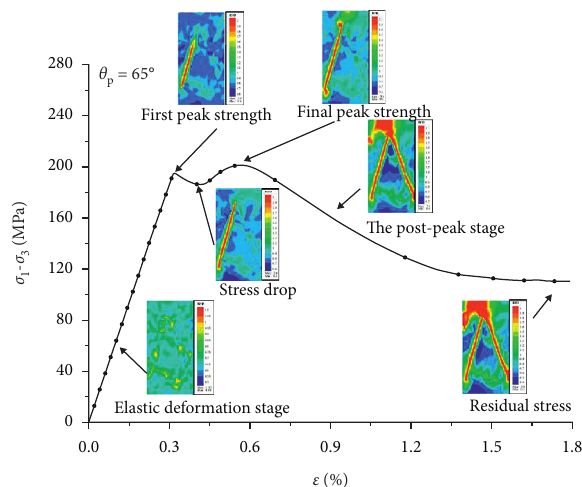
Figure 16: Crack initiation and coalescence process during the process of true triaxial